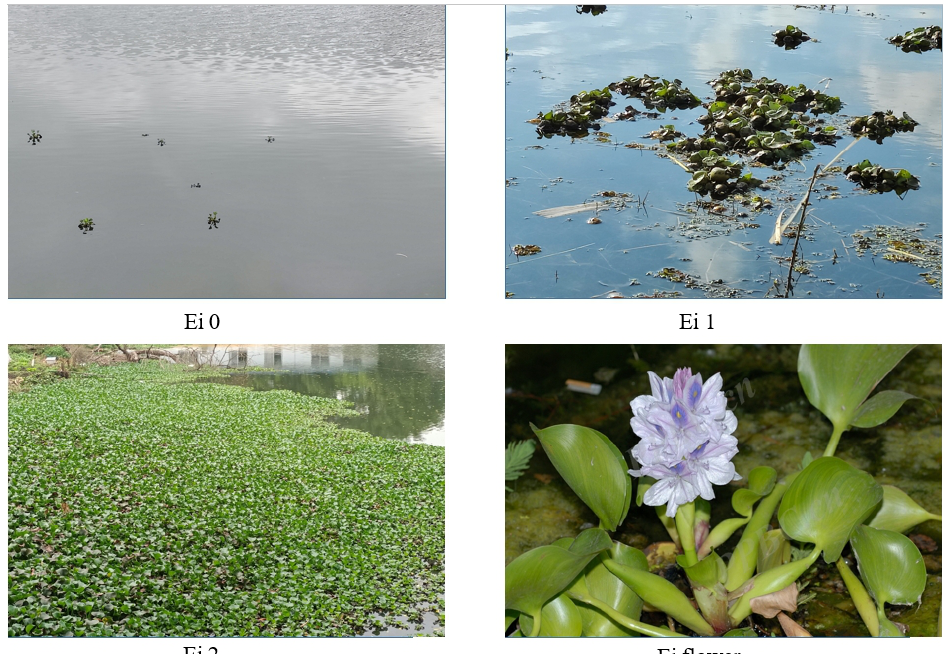
Figure 10. Different categories of Eichhornia crassipes.